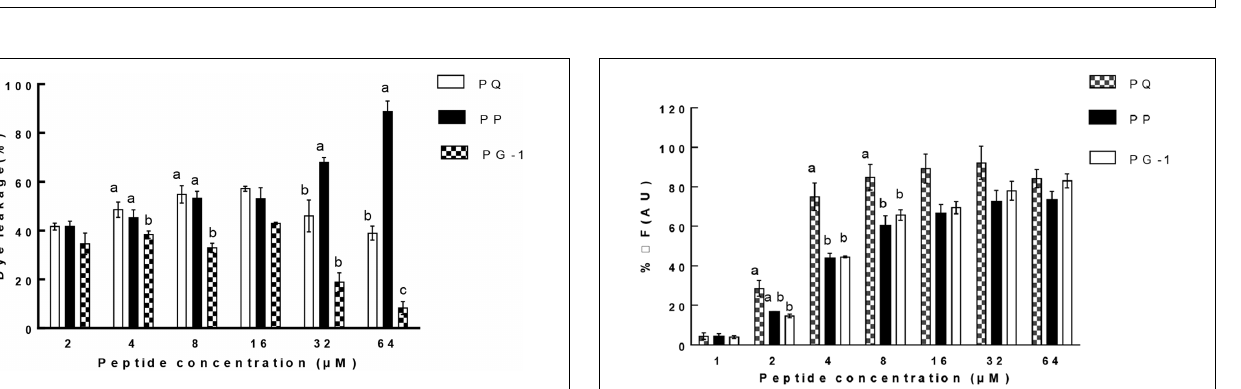
FIGURE 7 | Cytoplasmic membrane depolarization of E. coli UB1005 was measured by using the membrane potential-sensitive dye, DiSC3-5. (A) , PQ; (B) , PP; (C) , PG-1. 1, 2 µ M; 2, 4 µ M; 3, 8 µ M; 4, 16 µ M.